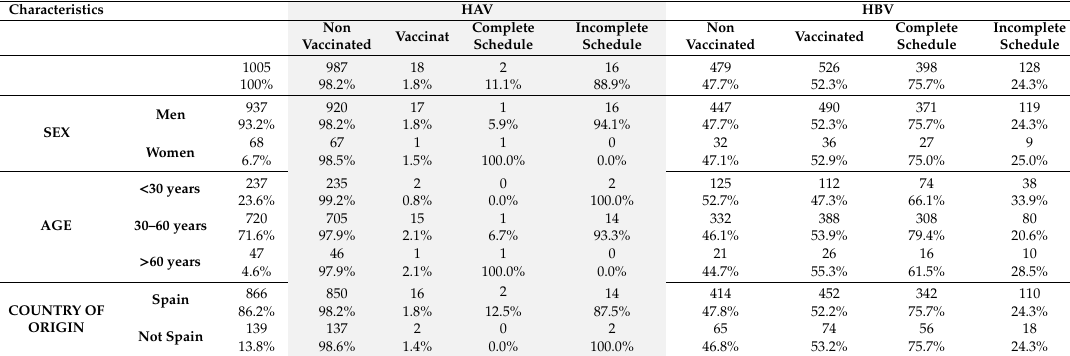
Table 2. Vaccination coverage for HAV and